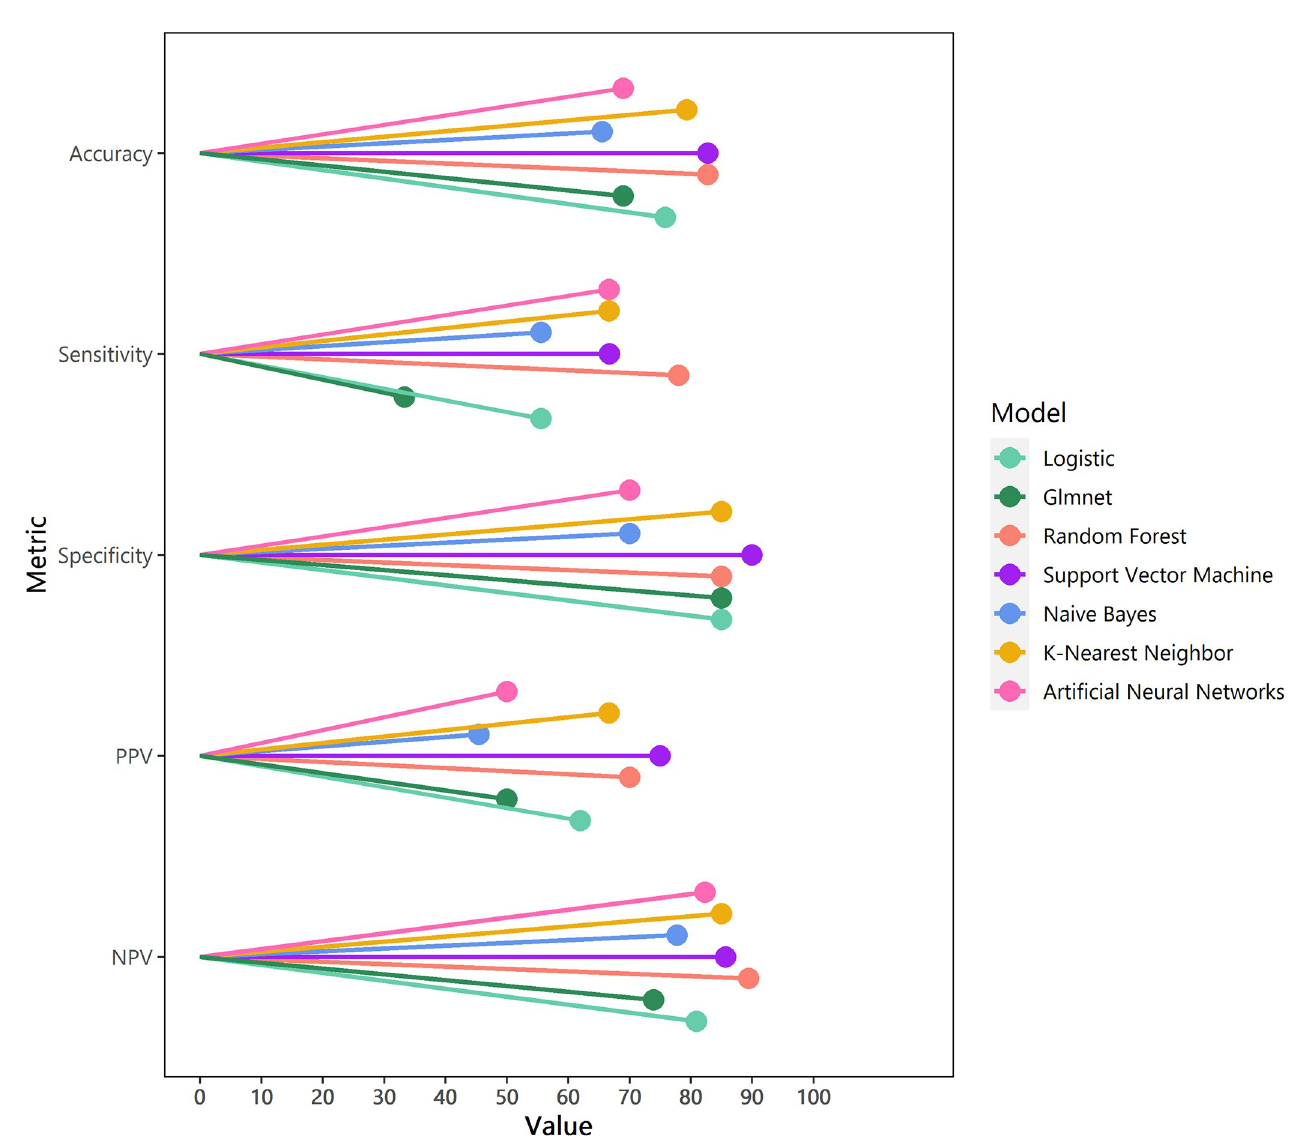
Fig 1. Algorithms performance in the validation